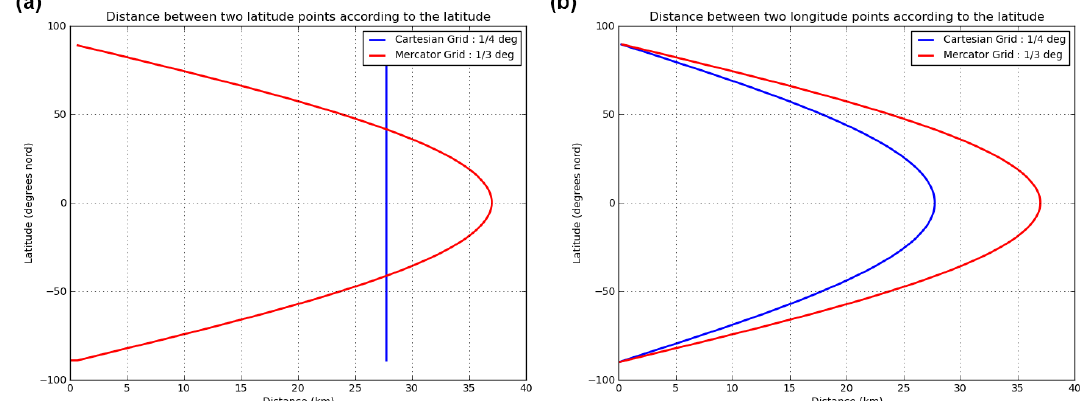
Figure C1. (a) Difference between two successive grid points on a meridional section as a function of latitude, at 1 / 4 ◦ × 1 / 4 ◦ Cartesian resolution (blue) and 1 / 3 ◦ × 1 / 3 ◦ Mercator resolution (red). (b) Same as left but for a zonal